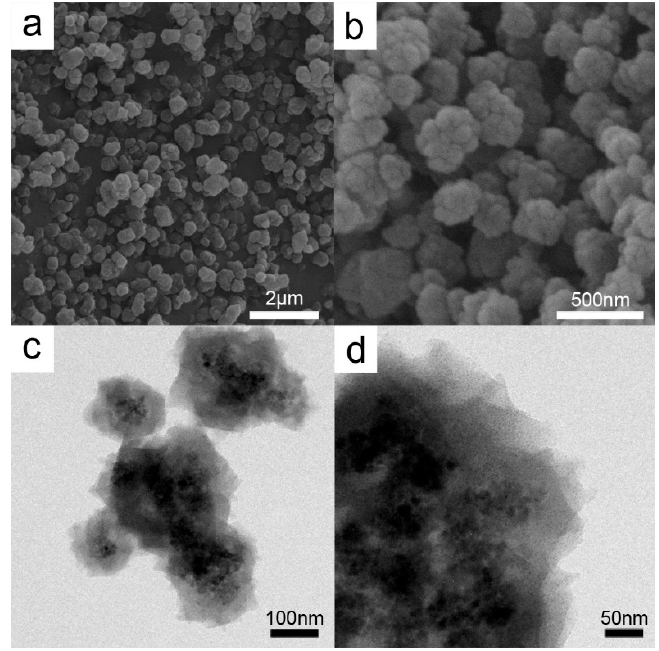
Figure 1. Representative SEM images ( a , b ) and TEM images ( c , d ) of Fe 3 O 4 @HKUST-1 core-shell structure.